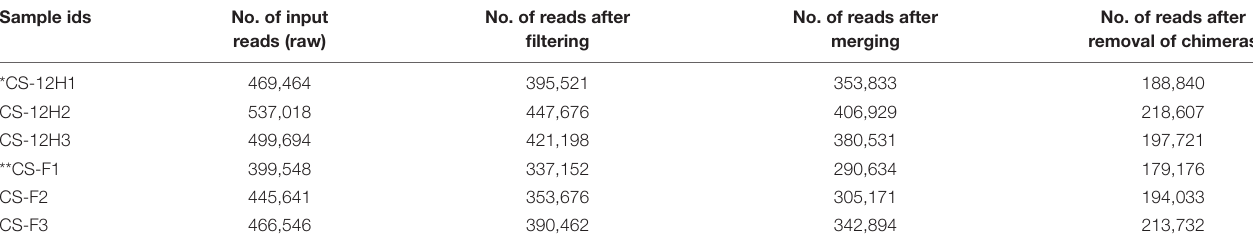
TABLE 1 | Bacterial preprocessing reads count reduction information for Kalparasa samples using the DADA2 R package. Sample ids